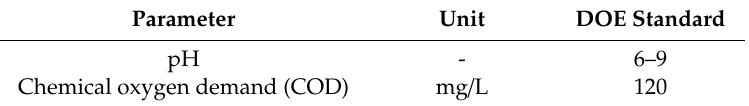
Table 1. Standards of discharge limit for pH and chemical oxygen demand